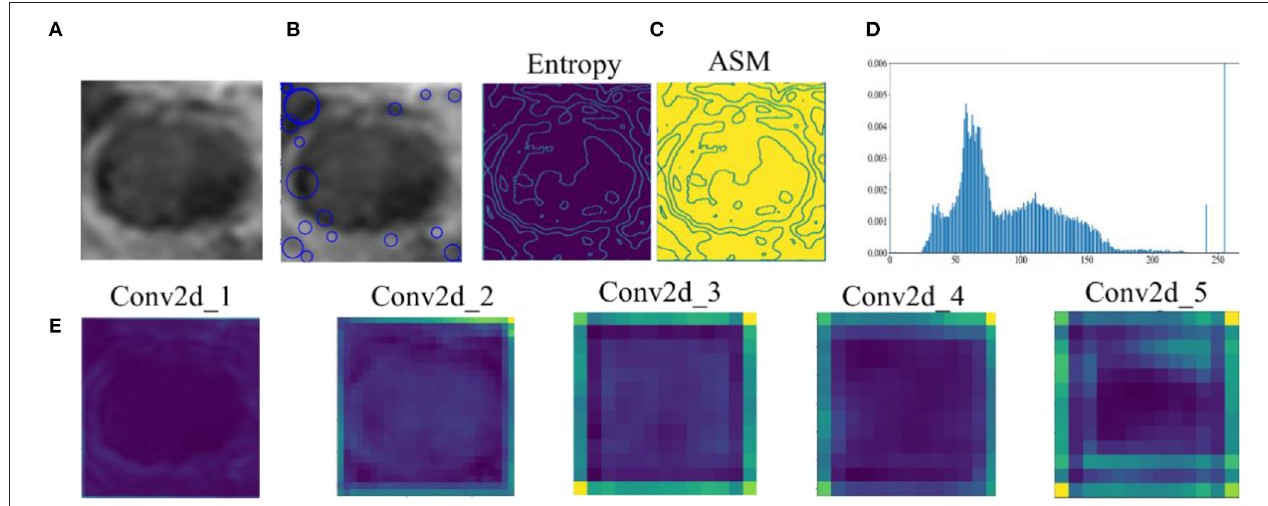
FIGURE 5 | Comparison of original data and features: (A) original data, (B) SIFT feature, (C) GLCM feature, (D) GLH feature, and (E) features by AlexNet pre-trained model extracted from convolutional layers